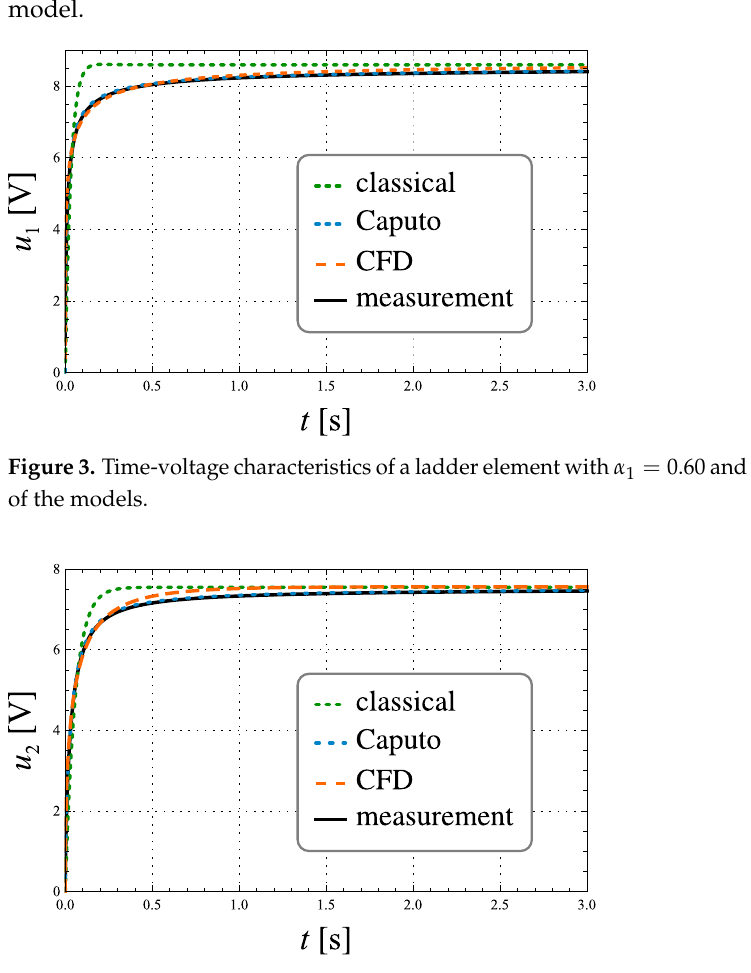
Figure 4. Time-voltage characteristics of a ladder system with α 2 = 0.75 and the theoretical responses of the